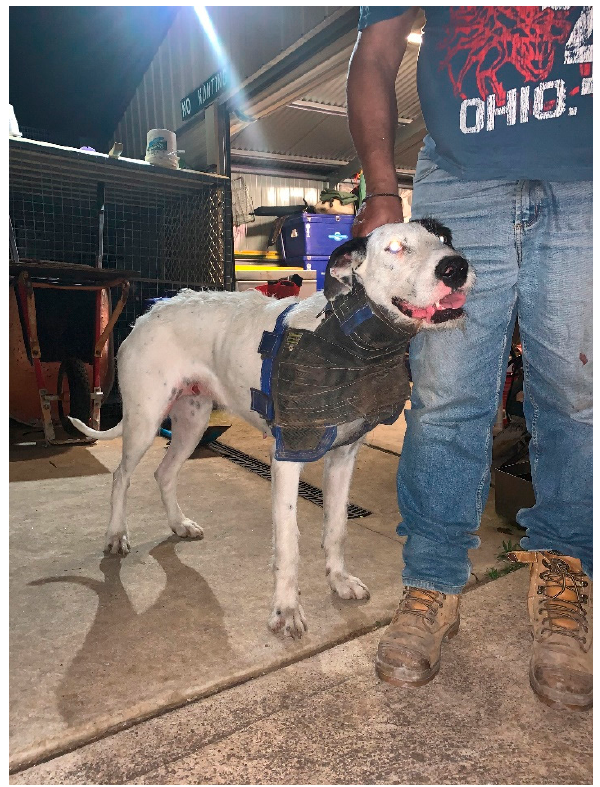
Figure 1. Bull Arab pig-hunting dog in protective armour in Australia ( author supplied).